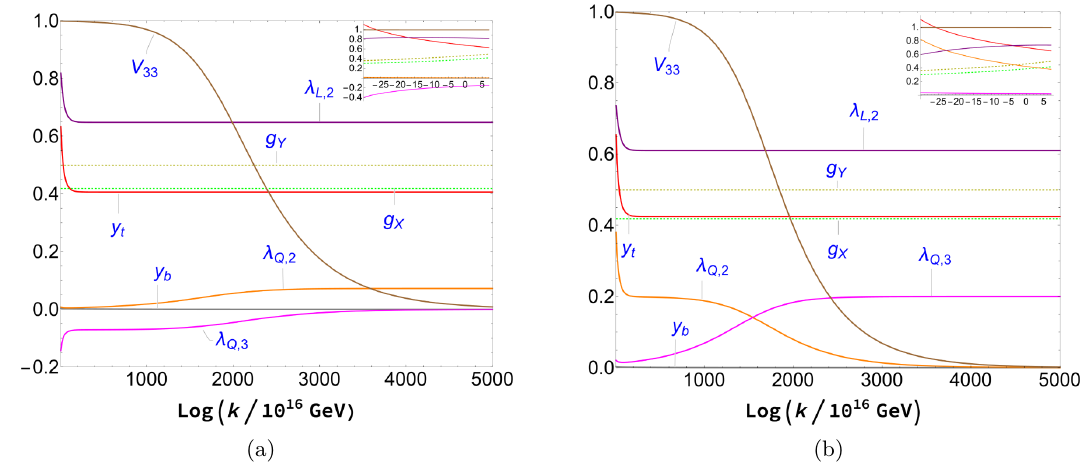
Figure 1 . (a) RG flow of the gauge and Yukawa couplings from trans-Planckian energies down to the EWSB scale for a scenario characterized by UV fixed point FP shown in the inset panel. (b) The same for FP